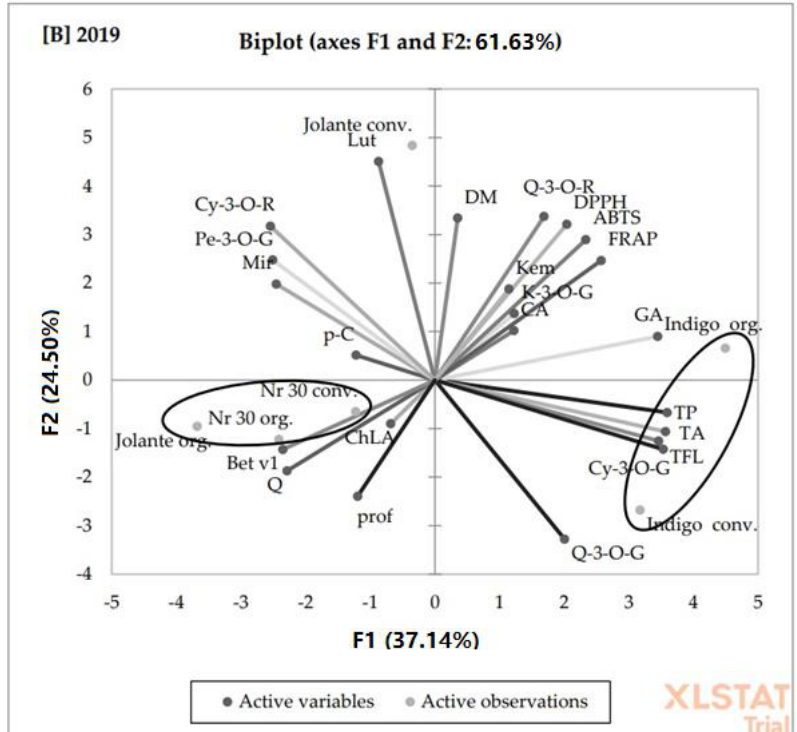
Figure 3. PCA analysis showing the relationship between the chemical composition and allergy potency of organic and conventional blue honeysuckle in both ( A ) 2018 and ( B ) 2019, dry matter (D.M.), total polyphenols (TP), gallic acid (GA), chlorogenic acid (ChLA), caffeic acid (CA), p -coumaric acid (p-C), total flavonoids (TFL), quercetin-3- O -rutinoside (Q-3-O-R), quercetin-3- O -glucoside (Q-3- O-G), kaempferol-3- O -glucoside (K-3-O-G), myricetin (Mir), luteolin (Lut), quercetin (Q), kempferol (Kem), total anthocyanins (TA), cyanidin-3- O -glucoside (Cy-3-O-G), peonidin-3- O -glucoside (Pe- 3-O-G), cyanidin-3- O -rutinoside (Cy-3-O-R), antioxidant activity (AA), Bet v1 (Bet v1), profilins